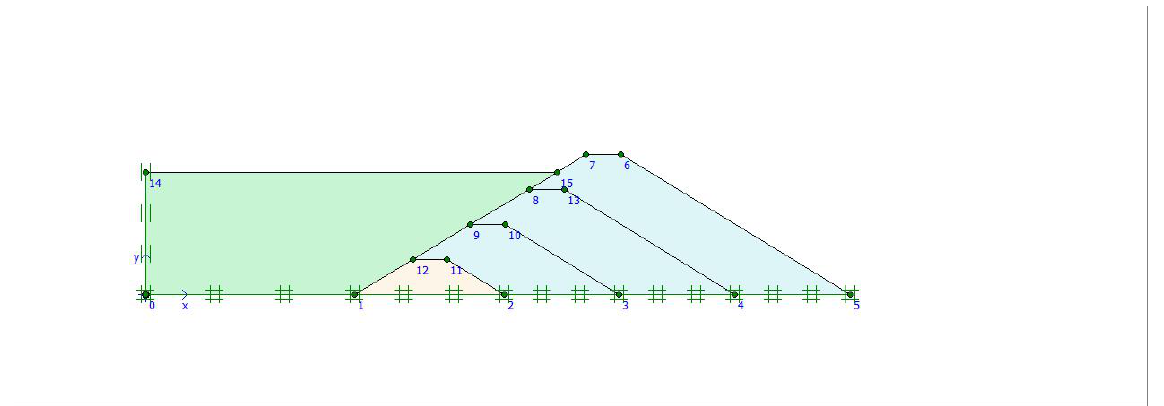
Figure 16. Cross section of downstream method dam with its materials